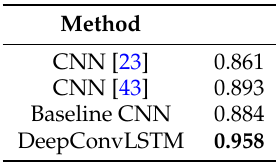
Table 9. F 1 score performance on the Skoda dataset.